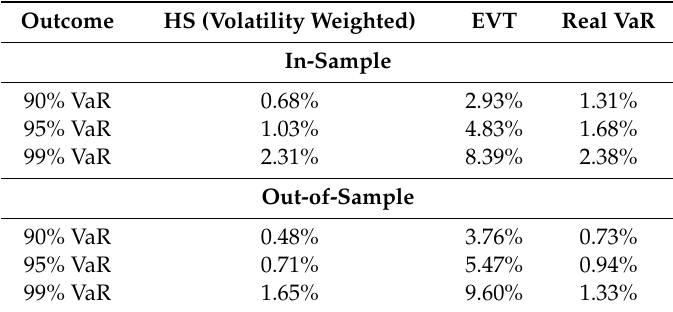
Table 7. VaR Summary